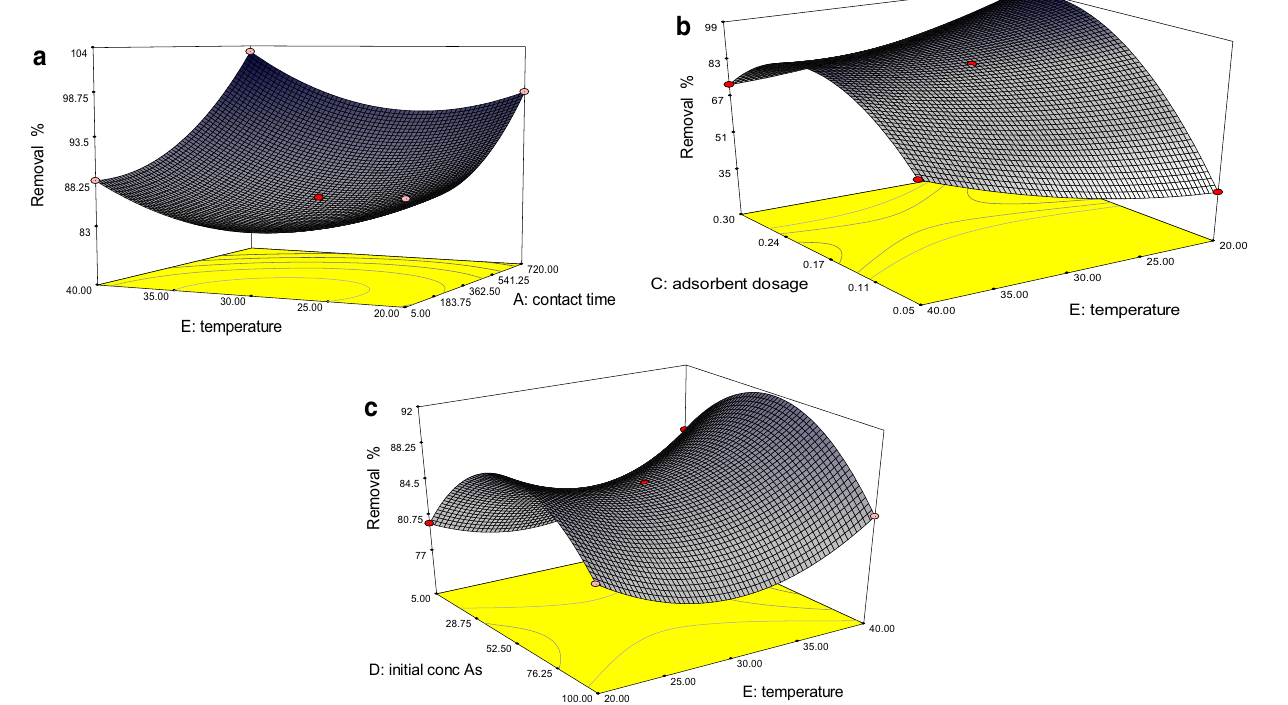
Fig. 3 3D response surface plots for As(III) removal vs a temperature (20–40 (cid:3) C) and contact time (5–720 min); b temperature (20–40 (cid:3) C) and adsorbent dosage (0.05–0.3 g); c temperature (20–40 (cid:3) C) and initial As(III) concentration (5–100 l g L - 1